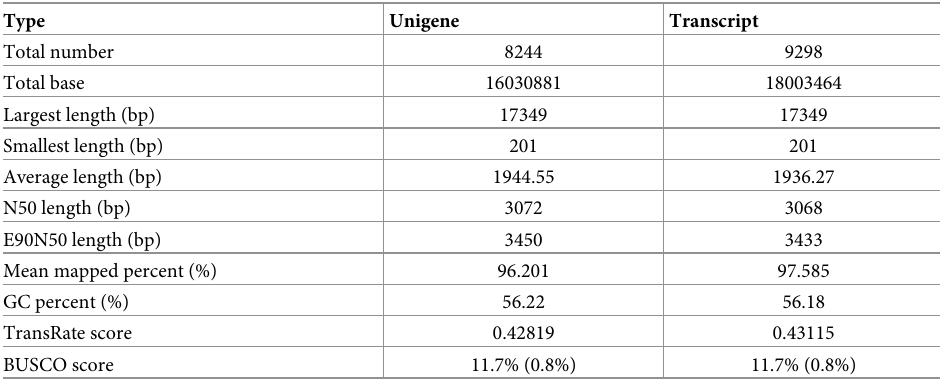
Table 2. Overview of the mRNA sequencing and assembly in P . cruentum